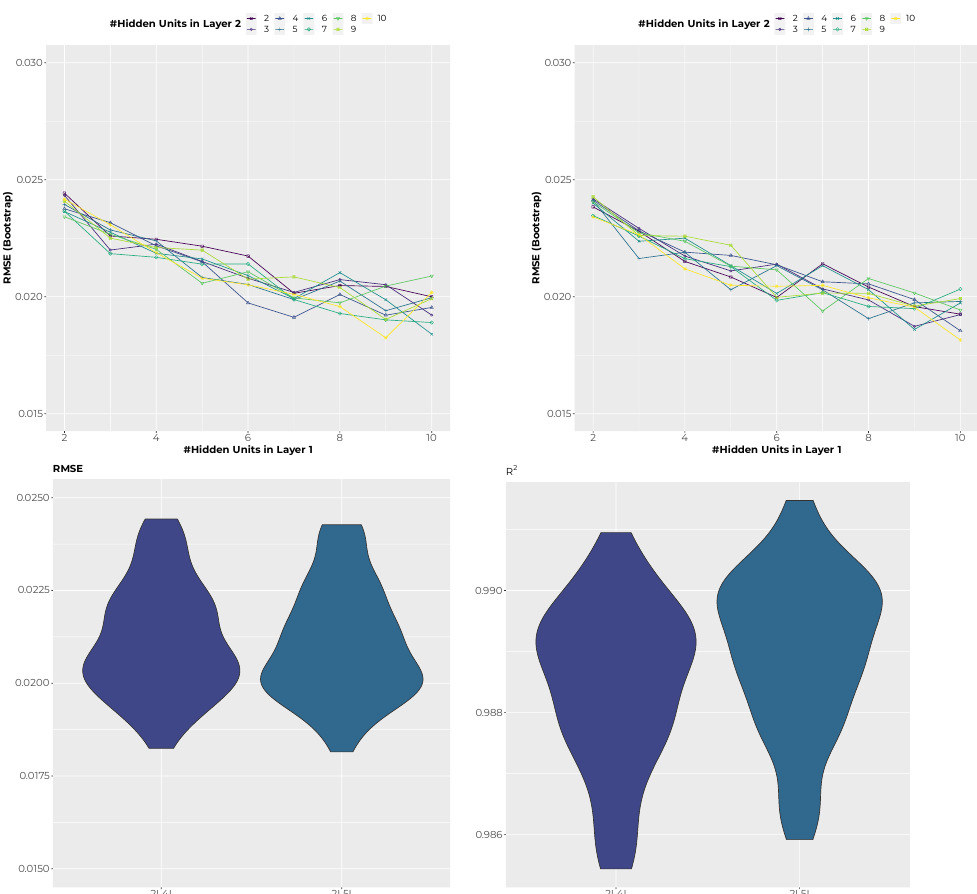
Figure 5. Results for the 81 ANN configurations. ( Top ) The RMSE variations for each ANN config- uration. ( Bottom ) Statistical analysis (RMSE and R 2 ) for each ANN configuration; 2L4I means two layers and four input parameters, while 2L5I is two layers and five input data points.